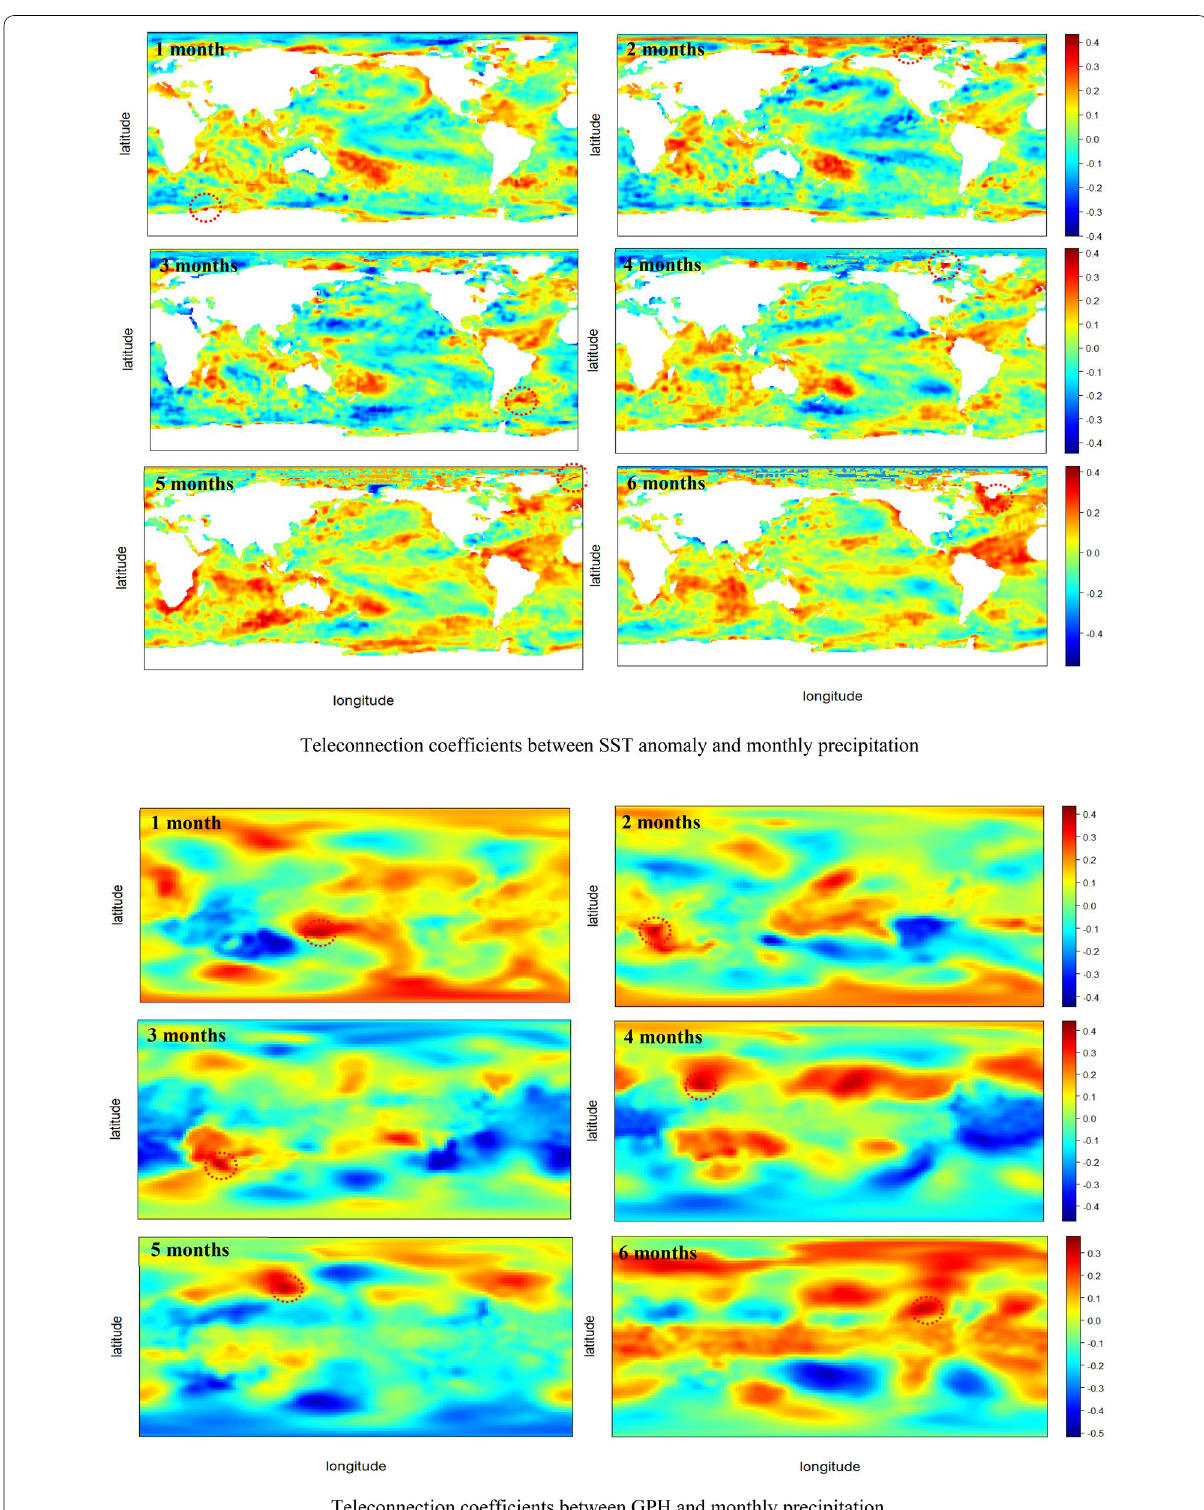
Fig. 24 Teleconnection coefficients between the global-scale climate indices and monthly